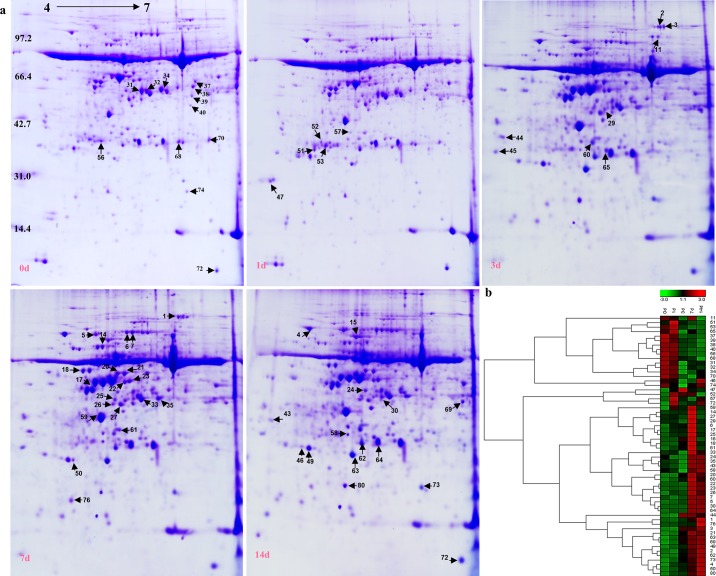
Two-dimensional eletrophoresis maps showing protein profiles of S. purpurea seedlings under a drought treatment for 0, 1, 3, 7 and 14 days.(A). Proteins were extracted from leaves and separated by isoelectric focusing on an IPG strip (pH 4–7, from left to right), followed by 12% SDS-PAGE. Proteins were visualized by CBB R-250 staining. Arrows indicate proteins showing significant changes in abundance under drought. (B) Hierarchical cluster analysis based on protein expression levels was performed with Genesis 1.7 software. Colors correspond to log-transformed values of protein fold-change ratios (shown in bar at top of figure).